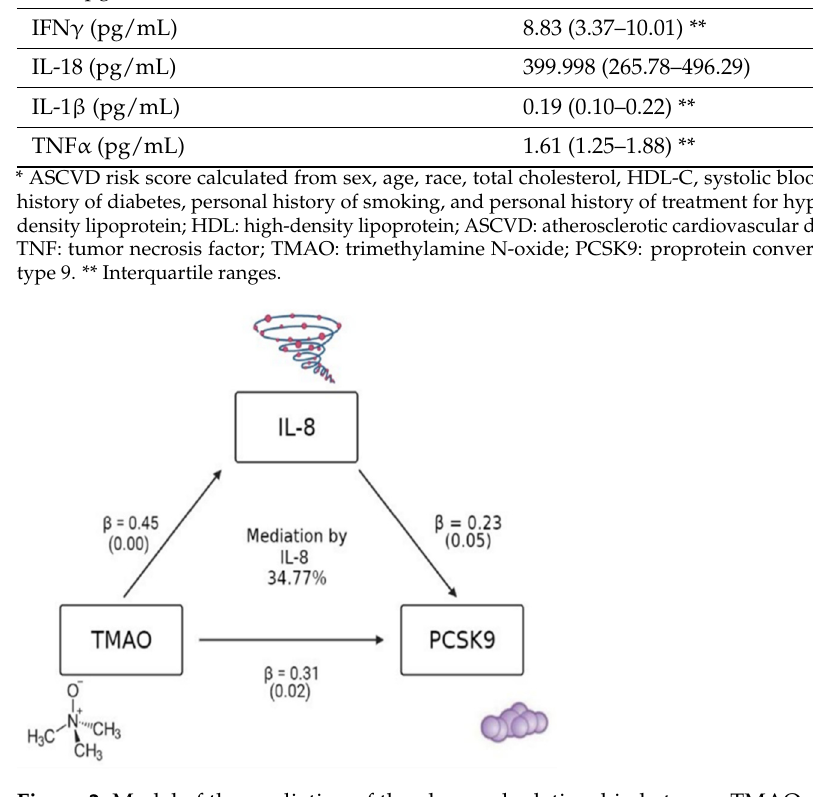
Figure 2. Model of the mediation of the observed relationship between TMAO and PCSK9 by IL-8. Model adjusted for BMI and ASCVD risk score, ( n = 60). ASCVD: atherosclerotic cardiovascular disease; BMI: body mass index; IL: interleukin; TMAO: trimethylamine N-oxide; PCSK9: proprotein convertase subtilisin/kexin type 9. Created with BioRender.com (accessed on 25 February 2022).